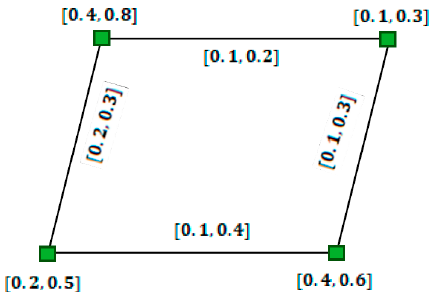
Figure 5. Interval-valued fuzzy graph compatible with Definition 5.